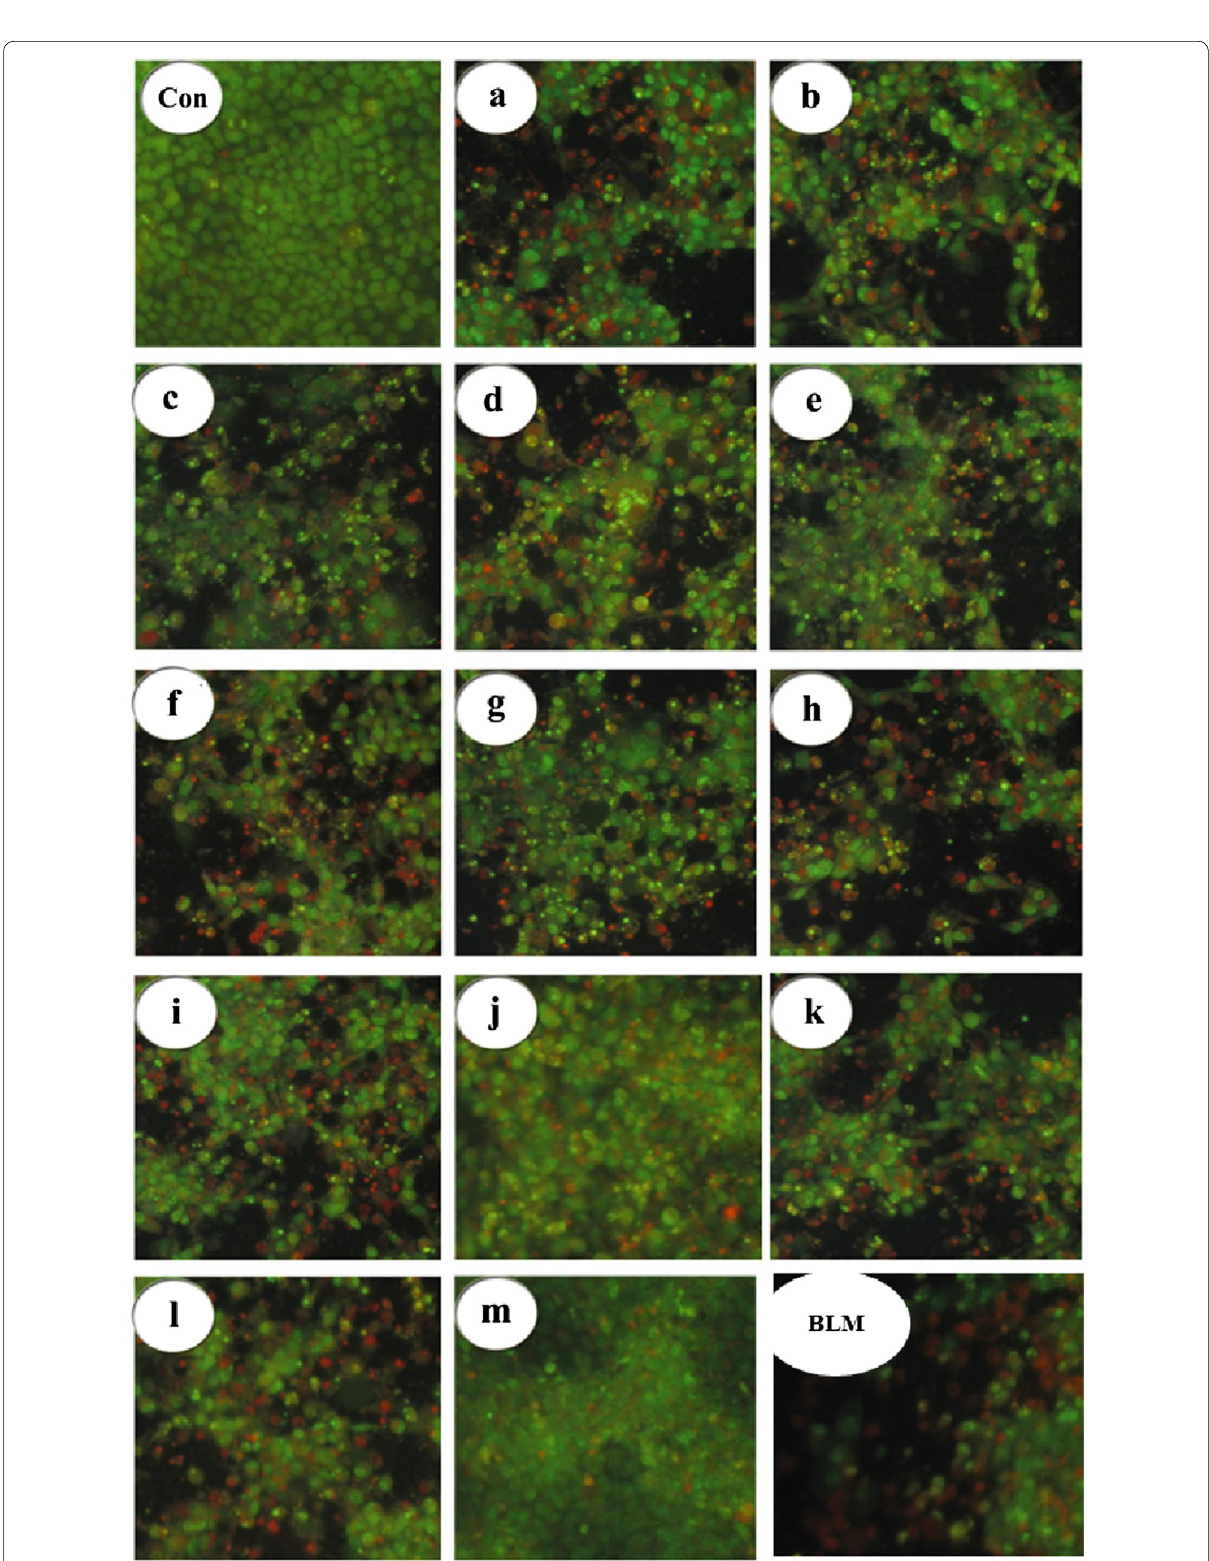
Fig. 5 Cytological features of synthesized compounds 5 ( a – m ) and bleomycin‑treated FaDu hypopharyngeal cancer cells (48 h). Magnification: ×